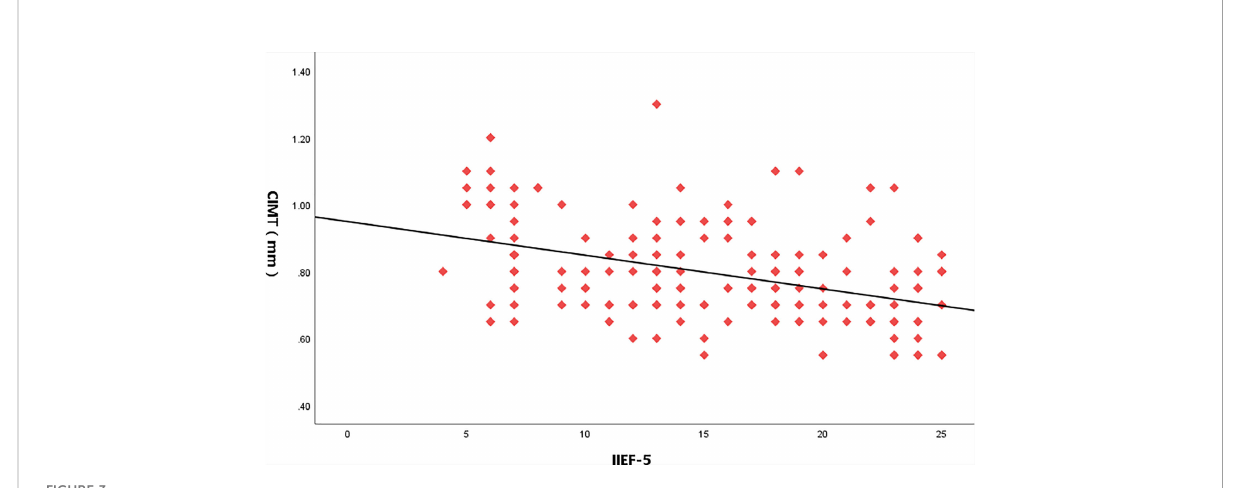
FIGURE 3 Relationship between IIEF-5score and CIMT values.